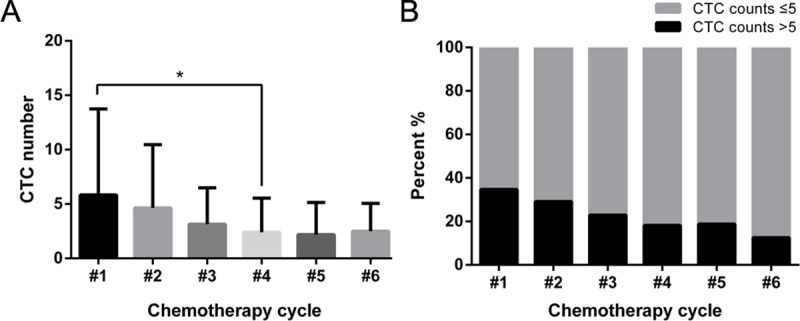
CTC numbers in patients undergoing chemotherapy cycles.A. CTC numbers of NSCLC patients based on different number of chemotherapy cycles. B. Percentage of patients with CTC numbers greater than 5/7.5 ml or not. * p < 0.05.